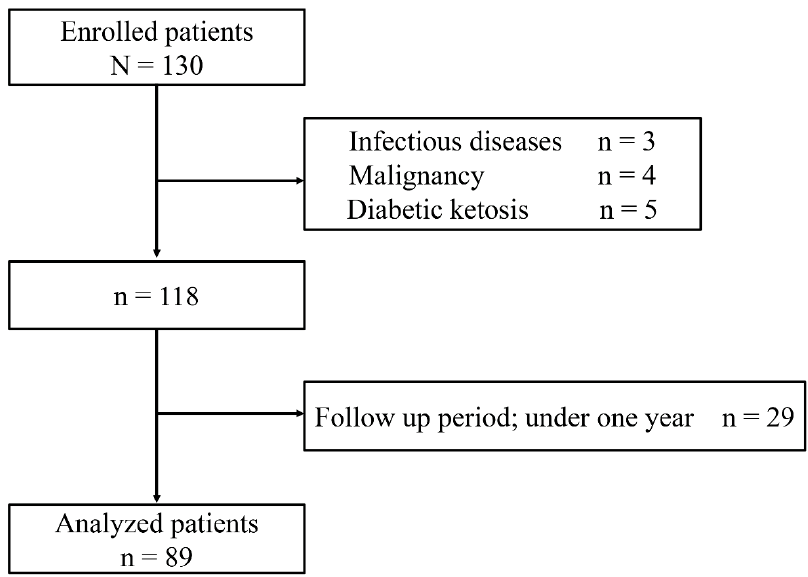
Figure 1. Flowchart of patient selection.